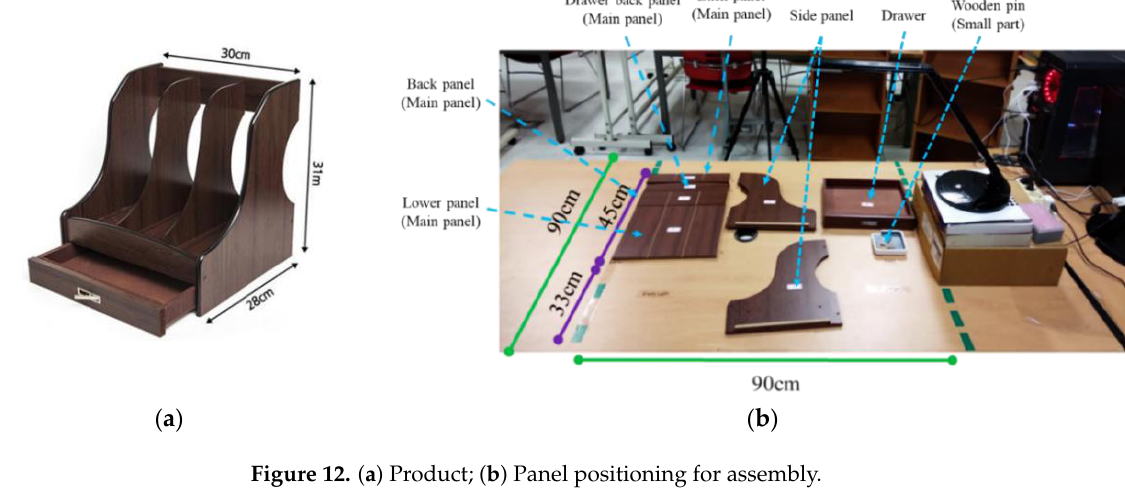
Figure 12. ( a ) Product; ( b ) Panel positioning for assembly.